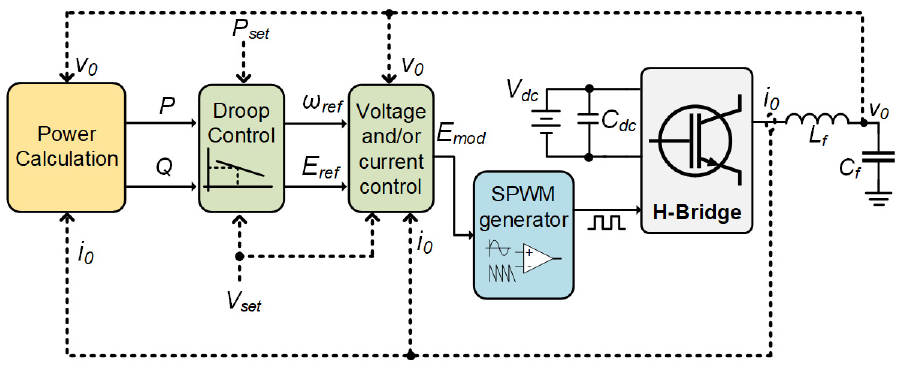
Figure 4. Block Diagram for the Generic Control Scheme of a Grid-Forming Inverter.